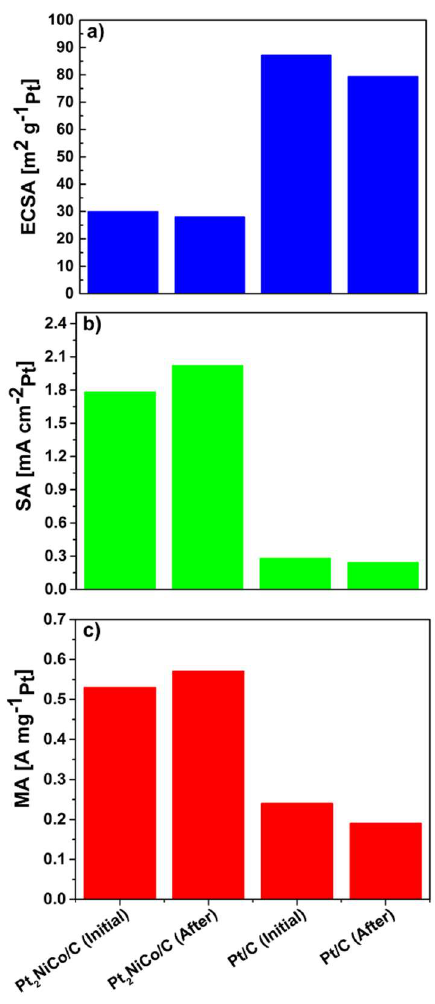
Figure 8. ( a ) electrochemical active surface area (ECSA), ( b ) specific activity (SA), and ( c ) mass activity (MA) of the Pt 2 NiCo/C and Pt/C nanocatalysts initial and after the 5000 CV cycles.